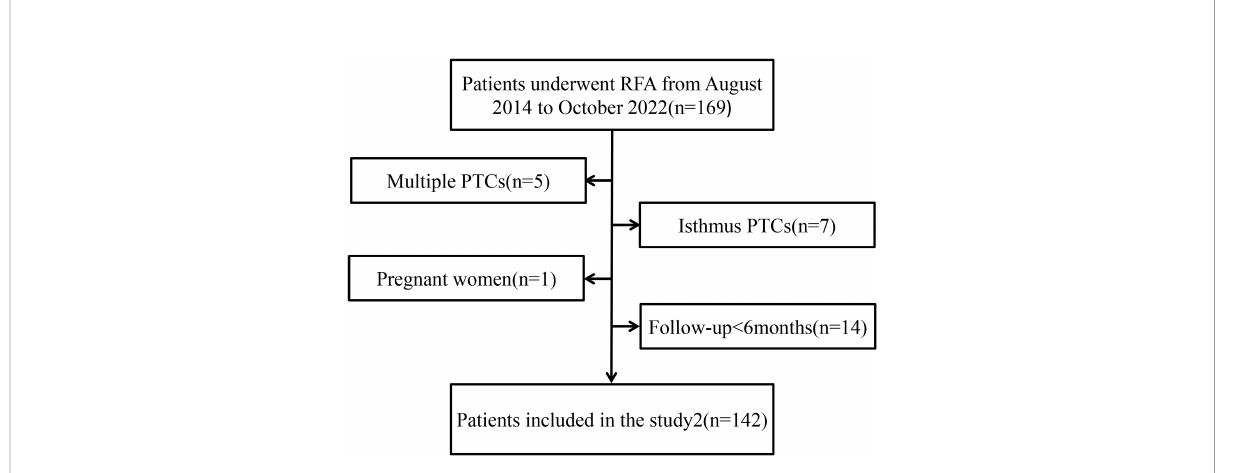
FIGURE 1 Research fl owchart. RFA, radiofrequerncy, ablation, PTC, papillary thyroid